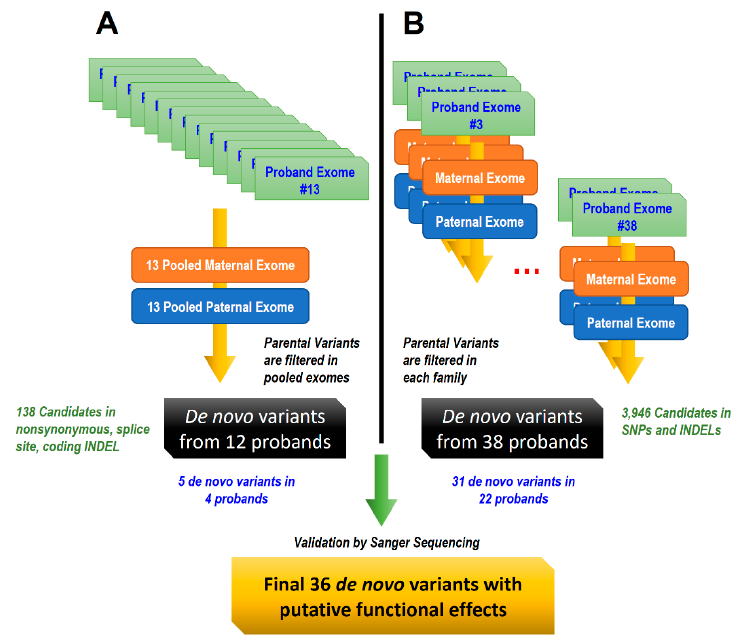
Figure 1. Design of a 51 Korean family trio cohort study. ( A ) First strategy: Variants from pooled parental exomes were removed to identify de novo variants from 13 probands. ( B ) Second strategy: Variants from both parental exomes were removed for each family.